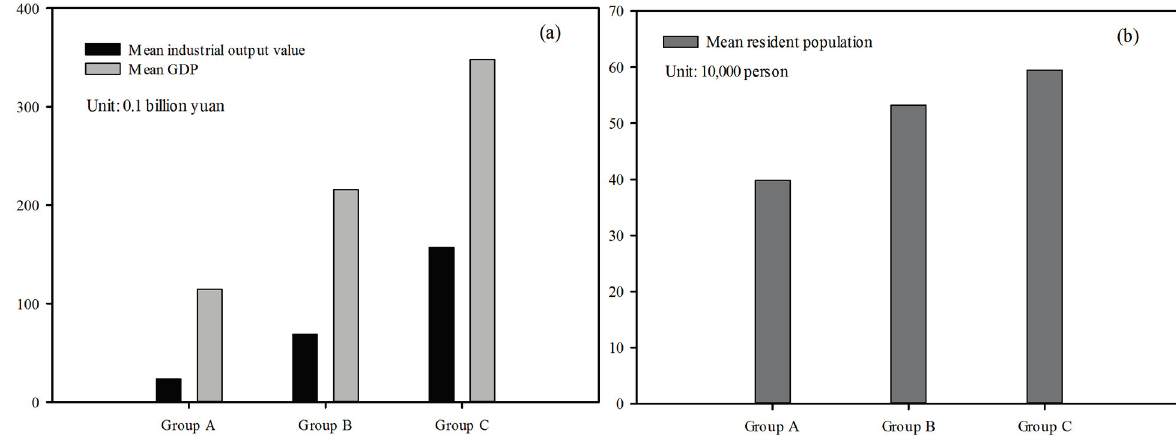
Figure 5. Mean values of the selected socio-economic indicators in Group A, B, and C: